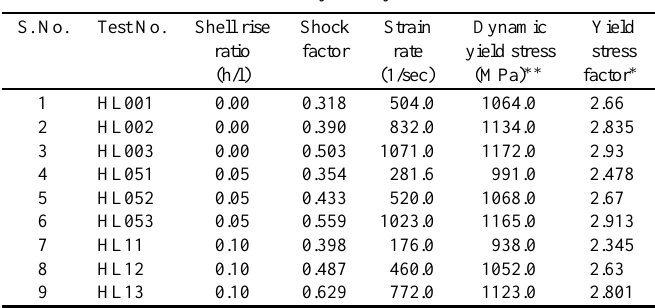
Table 3 Strain rate and dynamic yield stress